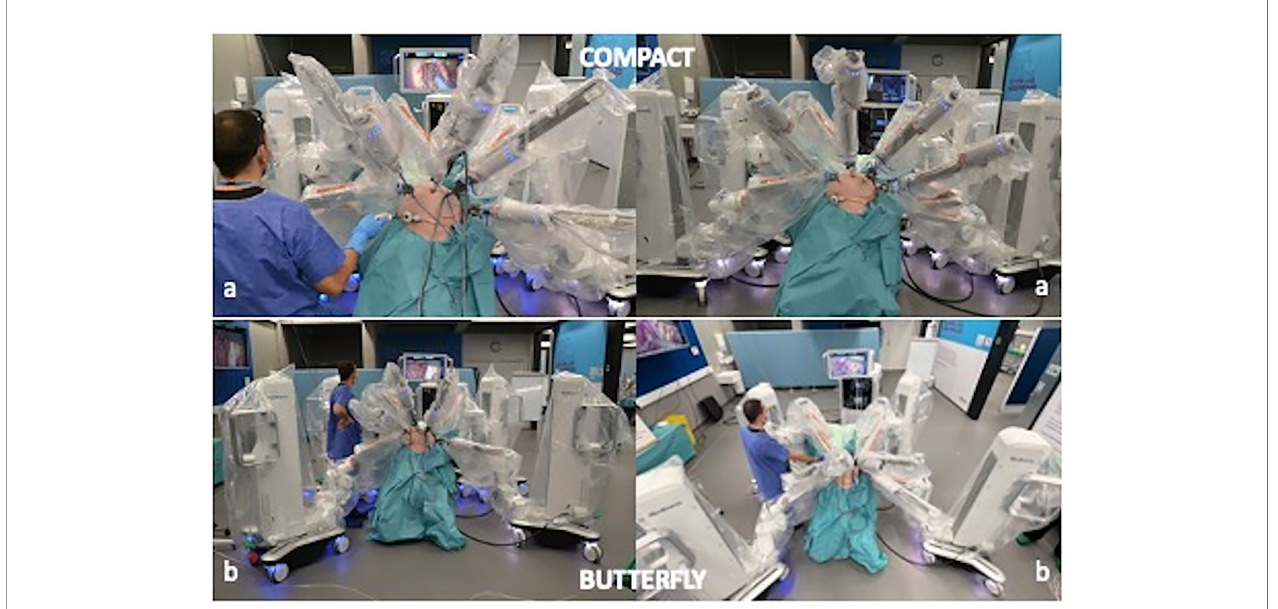
FIGURE 6 | (A) The “ compact ” docking con fi guration; (B) The “ butter fl y ” docking con fi